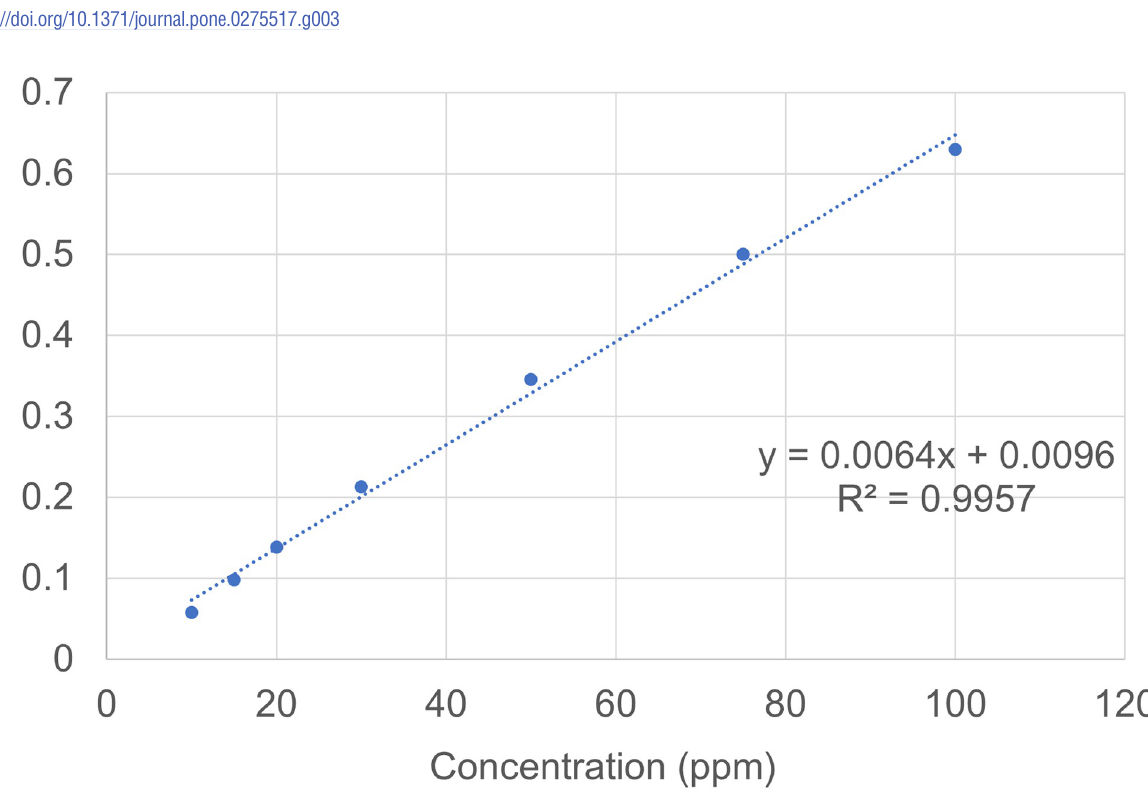
PLOS ONE | https://doi.org/10.1371/journal.pone.0275517 October 6, 2022 10 /